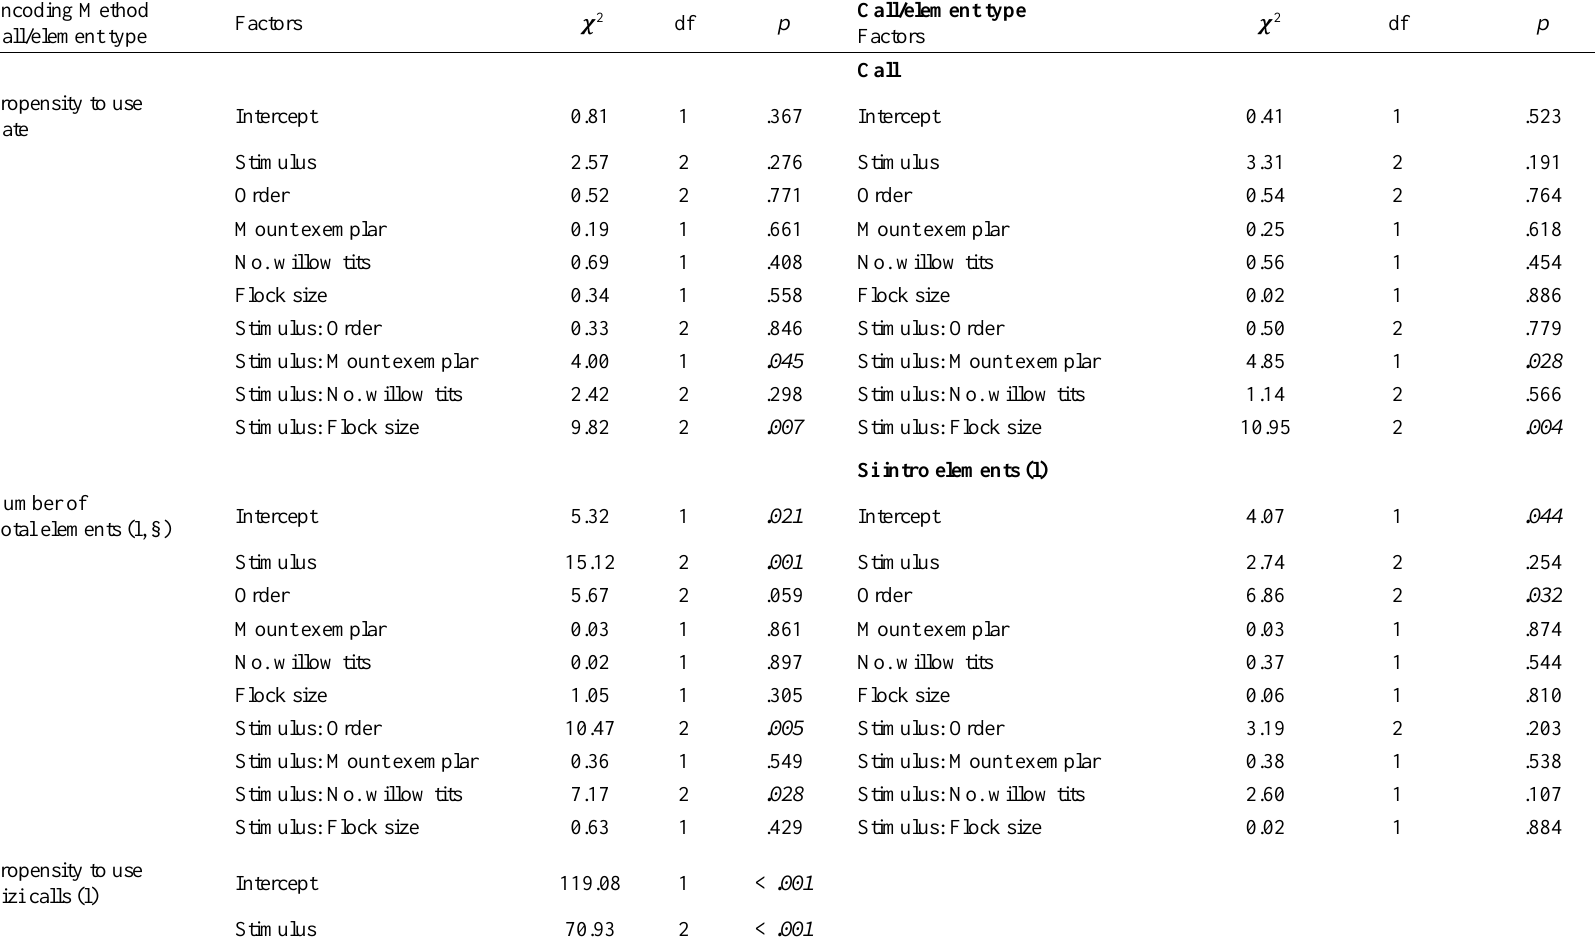
Test Results for Generalized and Linear Mixed Models Testing for Predator Type, Group Size (Conspecific and Flock Size) and Composition (Presence of Blue, Great, and Coal Tits) on Ways of Encoding Information about Predator Threat for Willow Tits. § Indicates the Model Residuals were not Normally Distributed, L and Bc Indicate that Data was Log (L) or Box-Cox (Bc) Transformed if Residuals were not Normal for Linear Mixed Models. Bonferroni Corrected P-Values Based on the Number of Models are